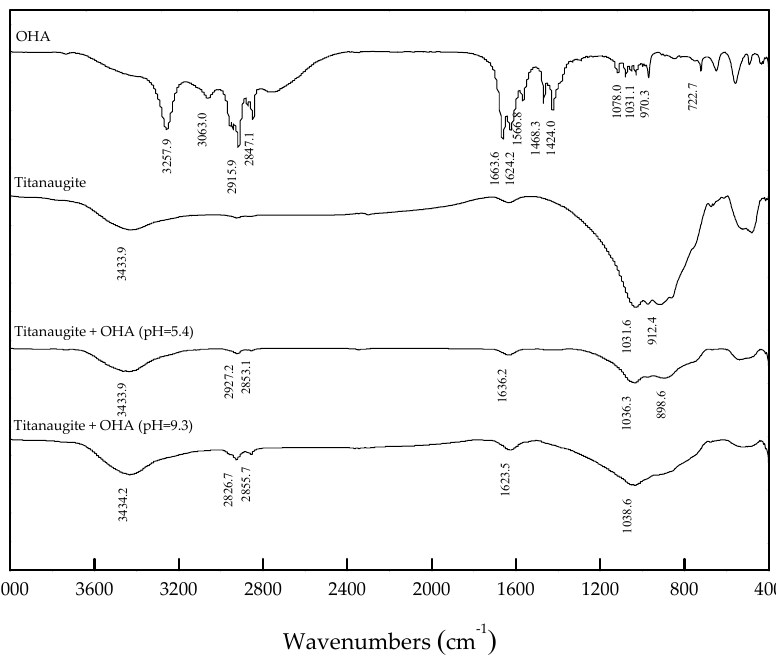
Figure 8. FT-IR spectra of the OHA and titanaugite with OHA at different pH levels.